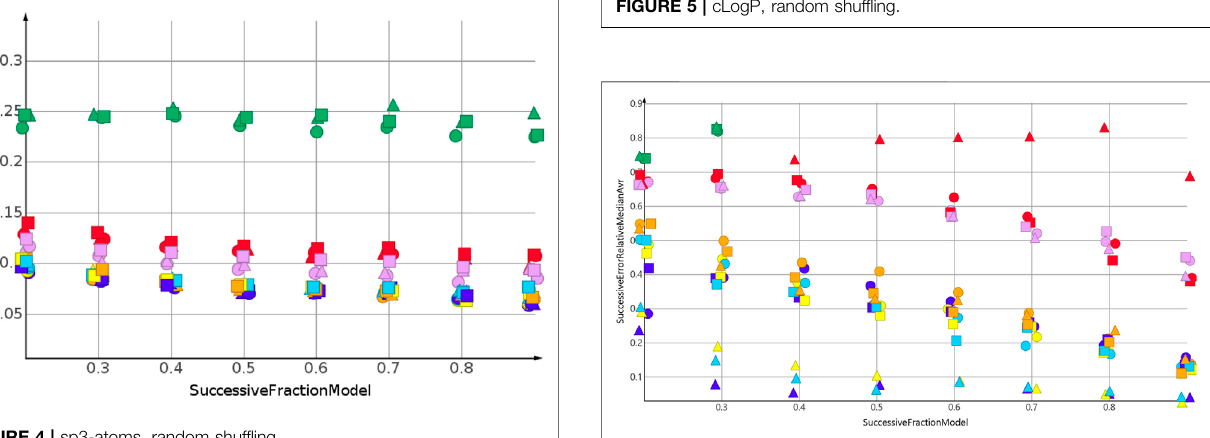
FIGURE 5 | cLogP, random shuf fl ing.